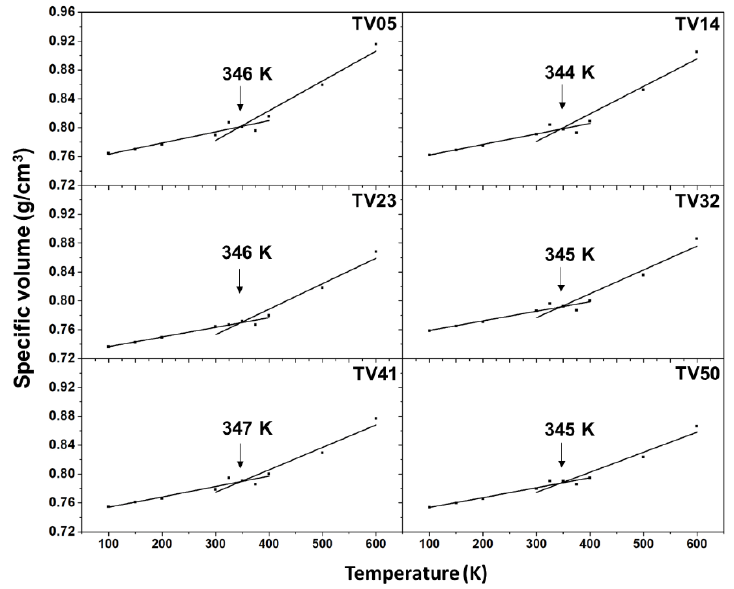
Figure 4. Temperature dependence of the specific volume for PET, PEV, and PET/PEV blends. The intersection of the two trended lines from low to high temperatures defines the T g of the polymer.